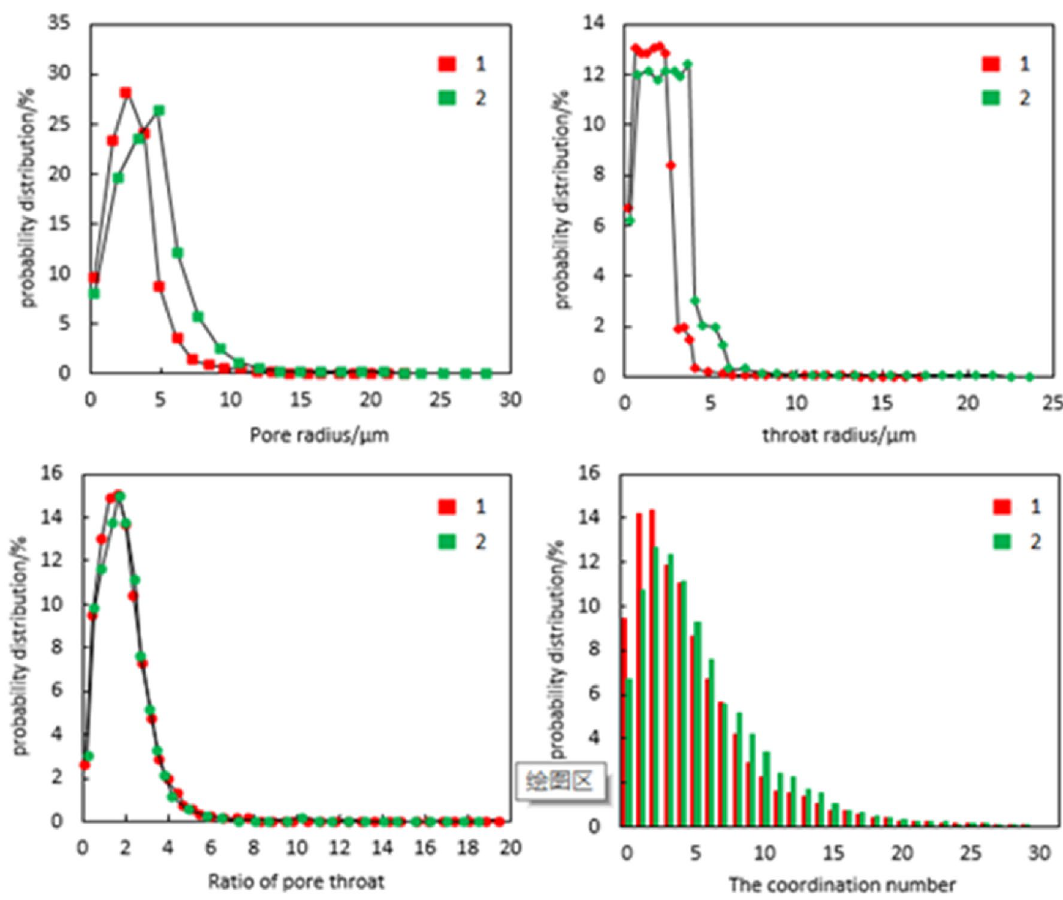
Fig. 7 Probability distribution of pore structure parameters of No.1 and No.2 rock samples from Ybei X